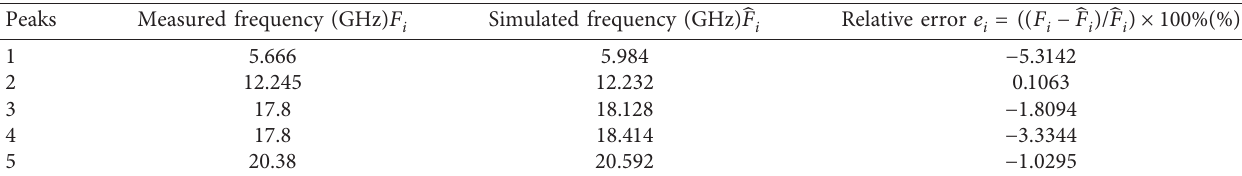
Table 6: The actual measurement and simulation data for frequency of each resonance peak.